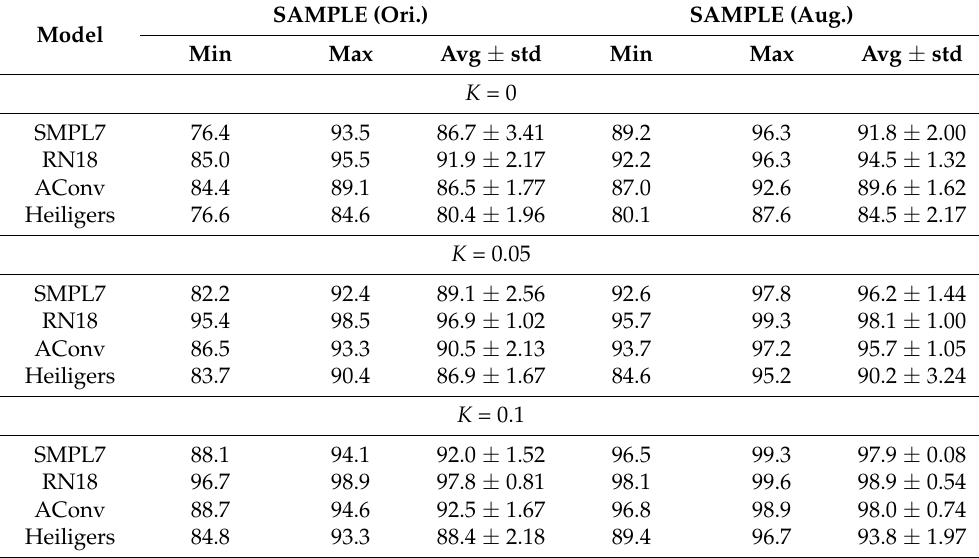
Table 6. Effect of contrast-based data augmentation on target classification accuracies. SAMPLE (Ori.) SAMPLE Model